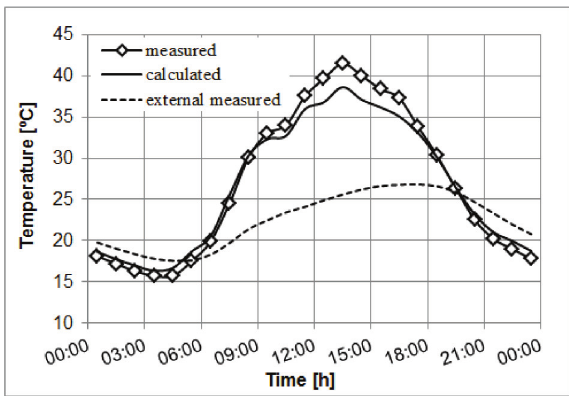
Fig. 6c. average hourly temperature of roof coating and external